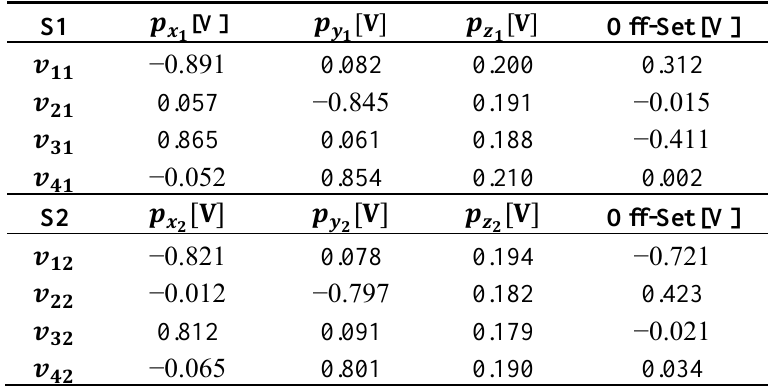
Table 1. Characteristic Matrix of the two developed sensor prototypes.